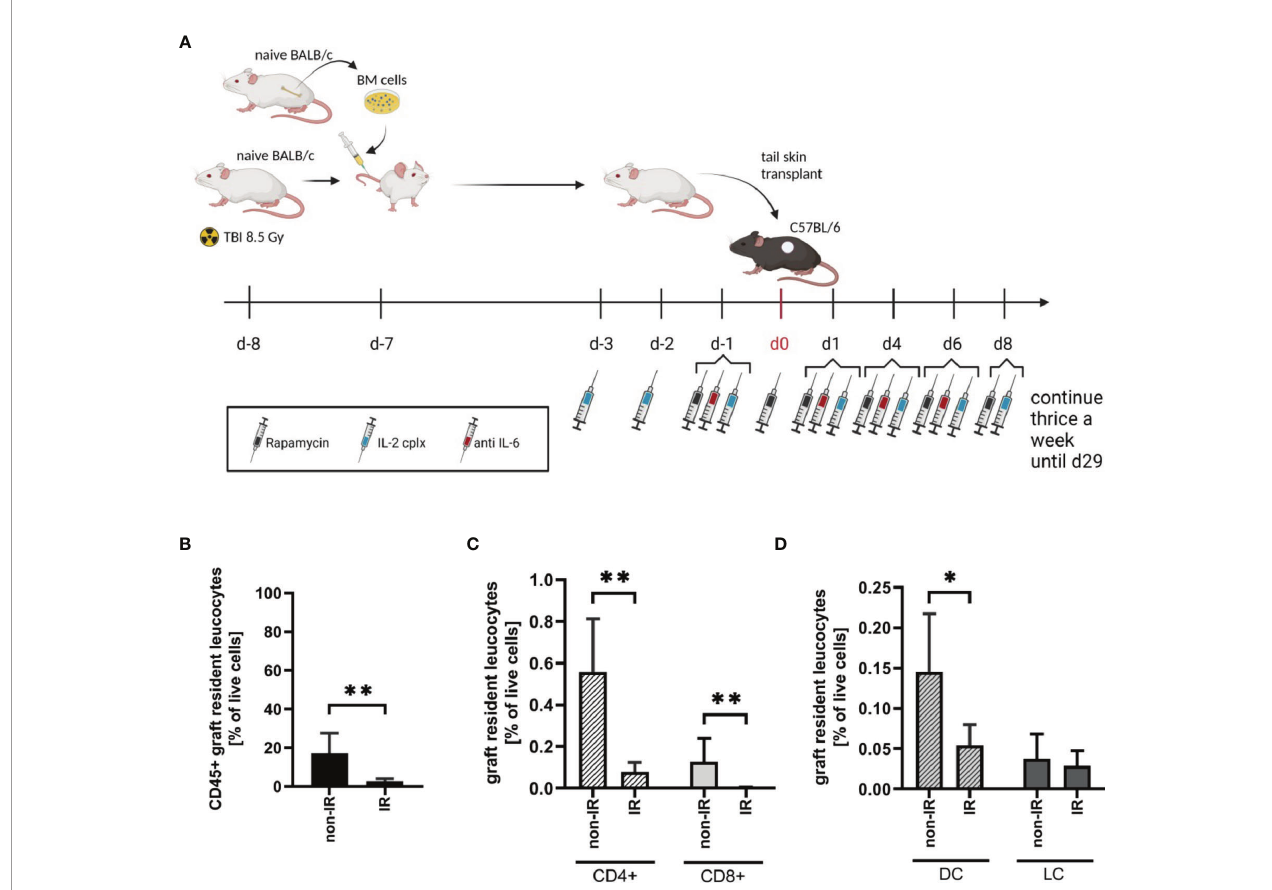
FIGURE 1 | Effective reduction of donor tail skin resident leucocytes 8 days after exposure to lethal total body irradiation. (A) Design of an allograft transplantation setting with reduced passenger leucocytes and IL-2 complex protocol treatment schema for indicated groups of skin allograft recipients. Donor mice were lethally irradiated (8.5Gy) d-8 and reconstituted with bone marrow cells of a naïve BALB/c mouse d-7. Donor tail skin was transplanted d0 onto recipient C57BL/6 mice. Indicated recipient mice in addition received a combination of IL-2 complexes, Rapamycin and a short term treatment of anti-IL-6. (B) Frequency of graft-resident CD45+ leucocytes within irradiated (IR; n = 7) and non-irradiated (non-IR; n = 4) skin grafts at time point of transplantation (d0) (mean 3% IR vs 17% non-IR; p = 0.006). (C) Graft-resident T-cell subsets within irradiated (n = 7) and non-irradiated (n = 4) skin grafts d0. Frequency of CD4+ (mean 0.079% IR vs 0.56% non-IR; p = 0.006) and CD8+ (mean 0.004% IR vs 0.13% non-IR; p = 0.006) T-cells within total graft-resident cells. (D) Frequency of graft-resident dendritic (CD45+ MHCII+ CD11c+; DC; mean 0.05% IR vs 0.15% non-IR; p = 0.03) and Langerhans cells (CD45+ MHCII+ CD11b+; LC; mean 0.03% IR vs 0.04% non-IR; NS) within IR and non-IR skin grafts d0 (n = 5 each). Analysis (B – D) was performed using fl ow cytometry and mean percentages are shown. Error bars indicate SD. (*P < 0.05; **P < 0.01; two-tailed t test with unequal